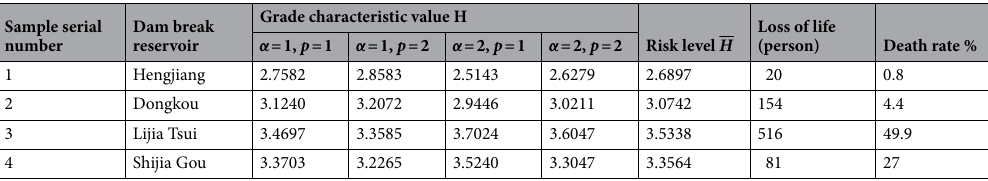
Table 4. Calculation results of risk level